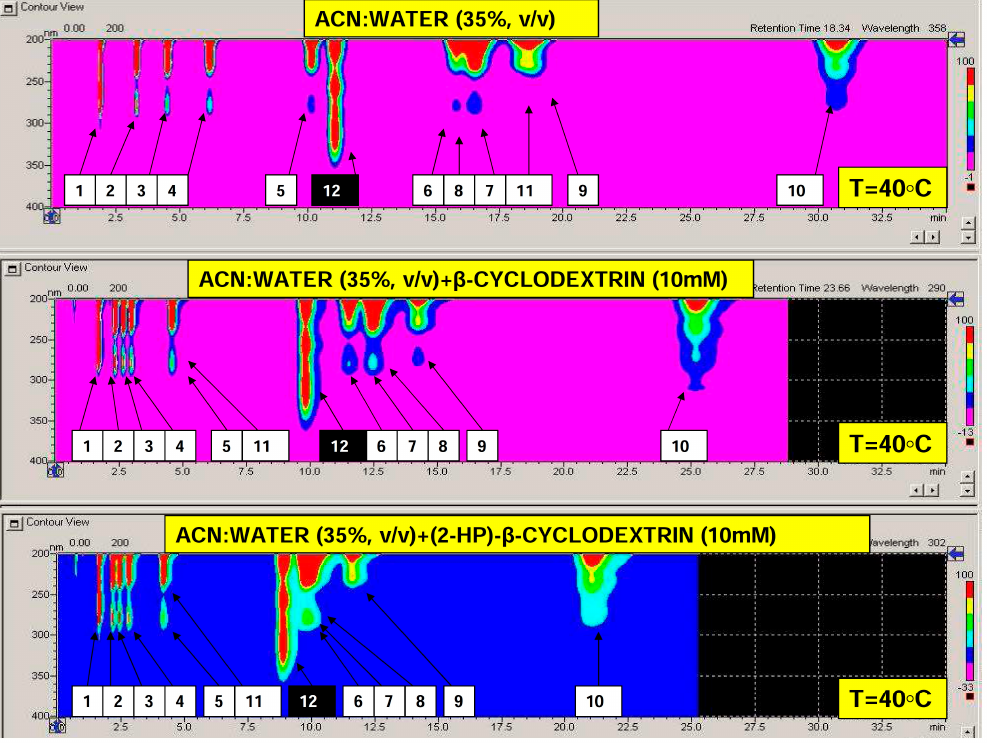
Figure 2. Isocratic separation of 12 substances (11 bisphenols and internal standard; analytes IDs according to data presented in Table 1A performed on 10 cm LC-18 column at temperature of 40 °C using plain binary mobile phase (top) and modified with different cyclodextrins at concentration of 10 mM (middle and bottom). Table 1. Values of chromatographic retention factor ( k ) of analytes separated on a 10 cm long LC-18 column at various temperatures and using mobile acetonitrile/water (35%, v / v ) unmodified ( A ) and modified phases β -cyclodextrin ( B ) and its hydroxypropyl derivative ( C ) at a concentration of 10 mM. The substance numbers correspond to the order of the analytes given in the Figure S1; Supporting Information.